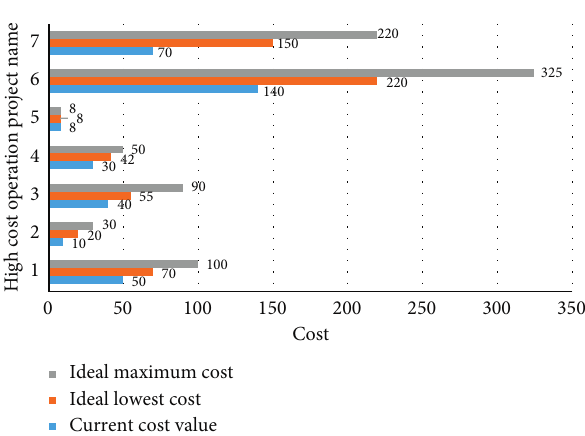
Figure 2: Cost analysis table of internal supply chain problems affecting supply